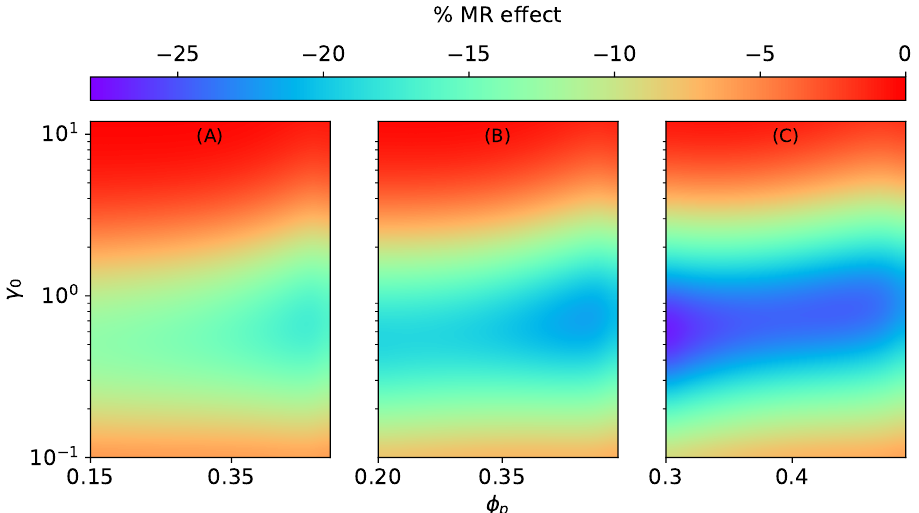
of an ellipsoidal MAE with an SC microstructure SC